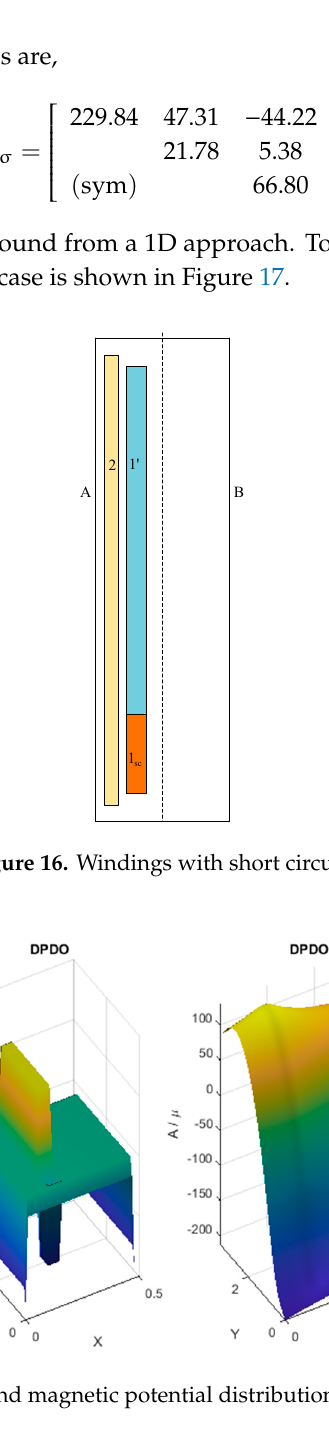
Figure 17. The current density and magnetic potential distribution for short circuited winding ‘1 ′ .